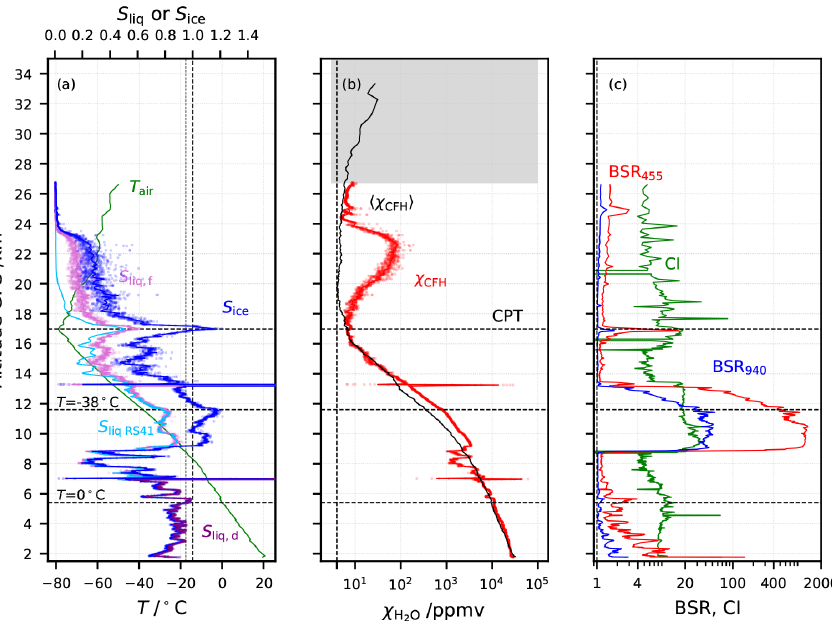
Figure 2. Flight NT011 in Nainital, India, on 15 August 2016. Lines: 1hPa interval-averaged values. Dots: 1s data. (a) Green: air temperature from the Vaisala RS41; light blue: saturation over water ( S liq , RS41 ) measured by the RS41; blue: ice saturation ( S ice ) from the CFH; purple: saturation over water ( S liq , d ) from the CFH considering the deposit on the mirror to be dew; pink: saturation over water ( S liq , f ) from the CFH considering the deposit on the mirror to be frost. Note that the condensate on the CFH mirror was forced to turn from dew to frost after the freezing cycle, at T frost =− 15 ◦ C. (b) Red: H 2 O mixing ratio from the CFH in ppmv; black: season average H 2 O mixing ratio excluding contaminated CFH profiles for the Nainital 2016 summer campaign (Brunamonti et al., 2018). Highlighted values with grey shading above the 20hPa level are possibly contaminated by outgassing from the balloon envelope. “CPT” marks the cold point tropopause. (c) Red: 940nm backscatter ratio from the COBALD; blue: same for 455nm; green: colour index (CI) from the COBALD.